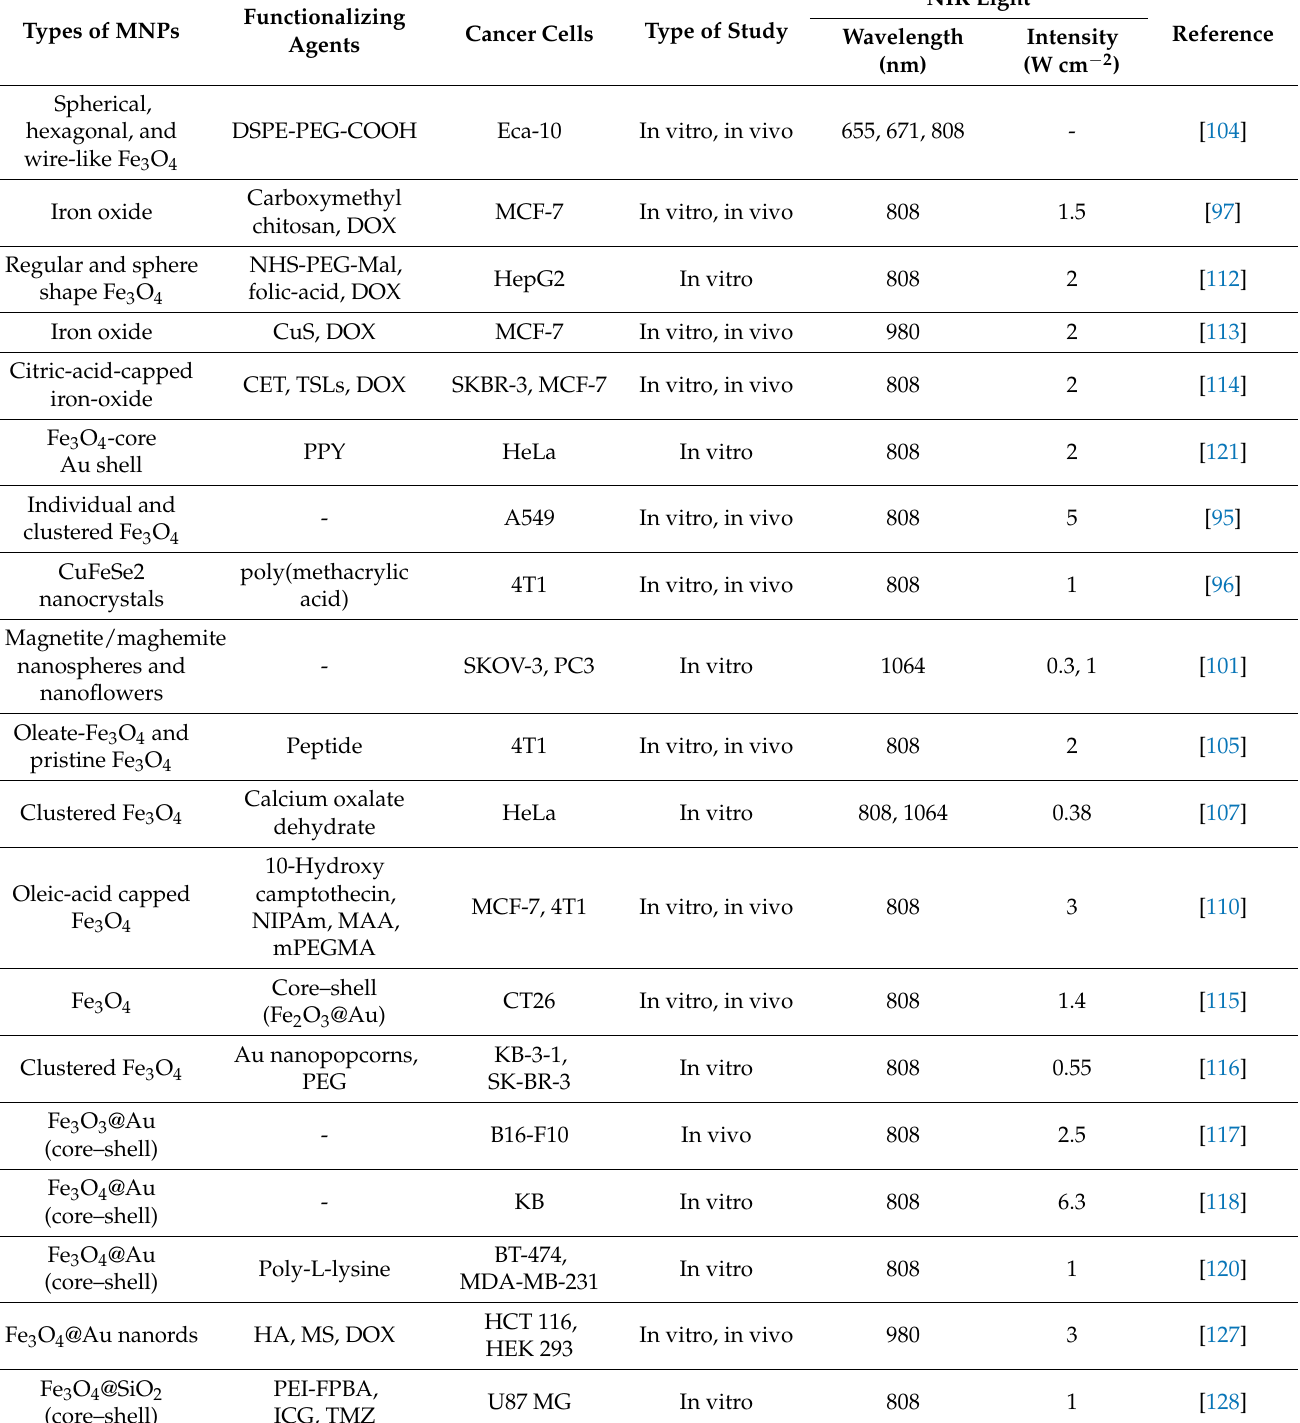
Table 2. Summaries of studies using functionalized MNPs for NIR-induced cancer